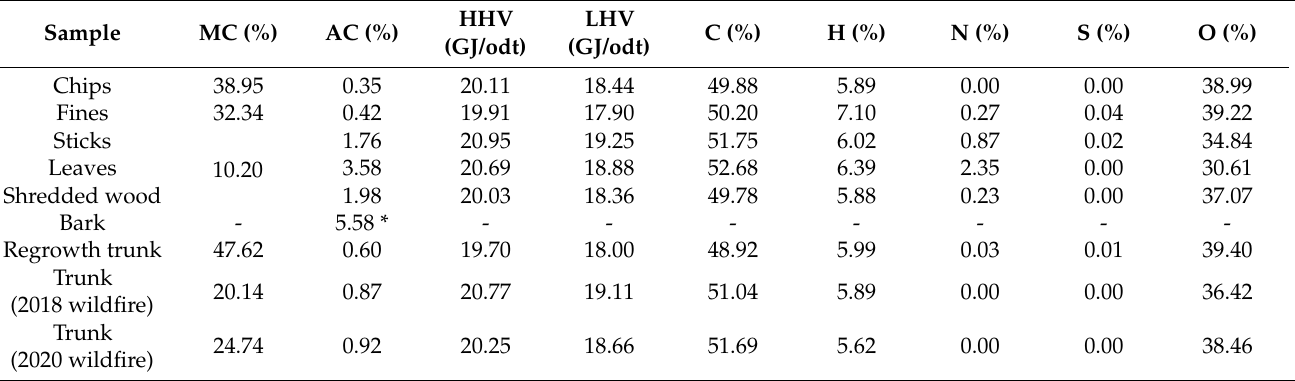
Table 1. Characteristics of Acacia mangium samples from the plantations on Melville Island. All values given are in reference to oven-dried weight. (All uncertainties in MC were 0.1% and in AC were less than or equal to 0.1%. The HHV measurements all had standard deviations less than or equal to 0.3 GJ/odt, except for the fines which was 1.0 GJ/odt. The standard deviations in all elemental measurements are less than or equal for C of 0.5%, for H of 0.1%, except for leaves